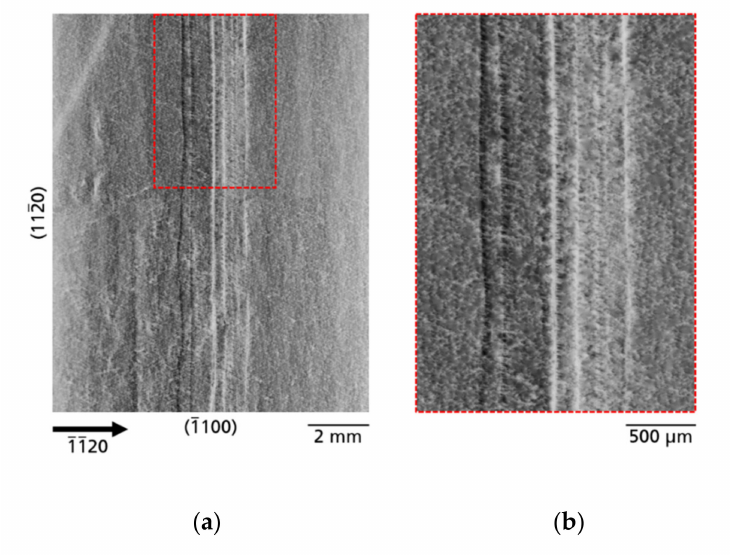
Figure 6. XRT images (1120 reflection) of the tiling seam from sample B: ( a ) six lines of defects are well visible; ( b ) highly enlarged area of the tiling seam.